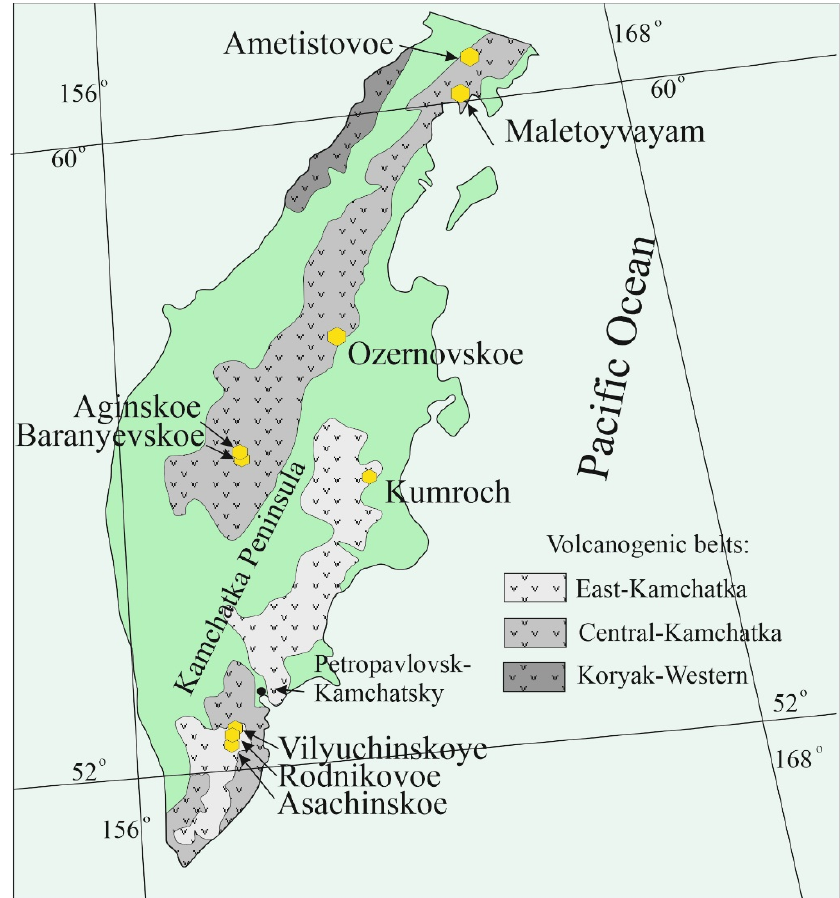
Figure 1. Map of volcanogenic belts showing the site of major gold deposits in the Kamchatka Peninsula [7]. East-Kamchatka: Quaternary basalts; Central-Kamchatka: Neogene andesites; Koryak- Western: Oligocene-Lower Miocene volcanogenic sediment [8].